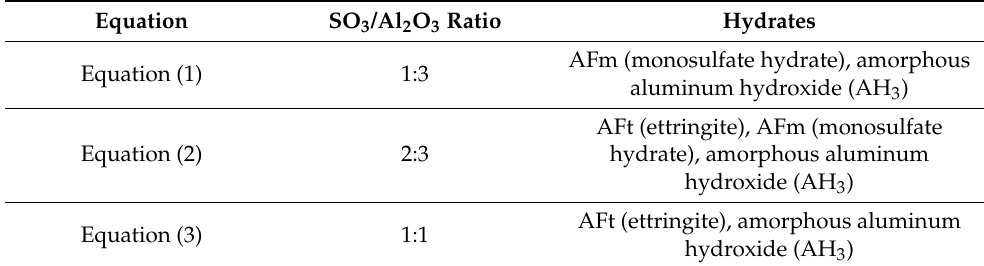
Table 3. Hydrates produced for each SO 3 /Al 2 O 3 ratio.